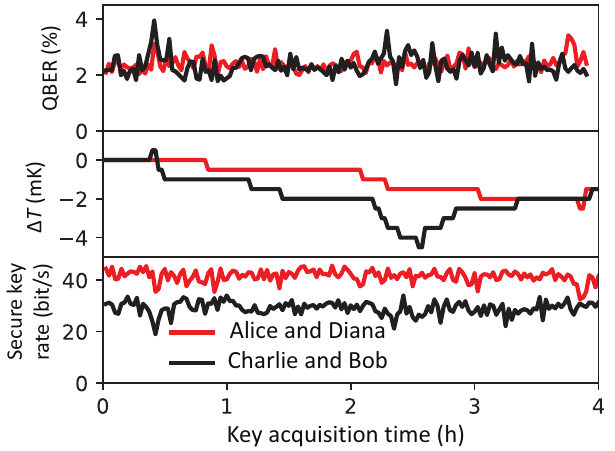
FIG. 5. The estimated secure key rates and QBERs for simul- taneous key exchange over fiber spools with a total length of 47.5 km for Alice and Diana (red) and 60.5 km for Charlie and Bob (black) with a μ in the range of 0.03. (cid:6) T denotes the temperature adjustments made at Alice’s and Bob’s receiver interferometers. Each data point represents one 90 s-long run.